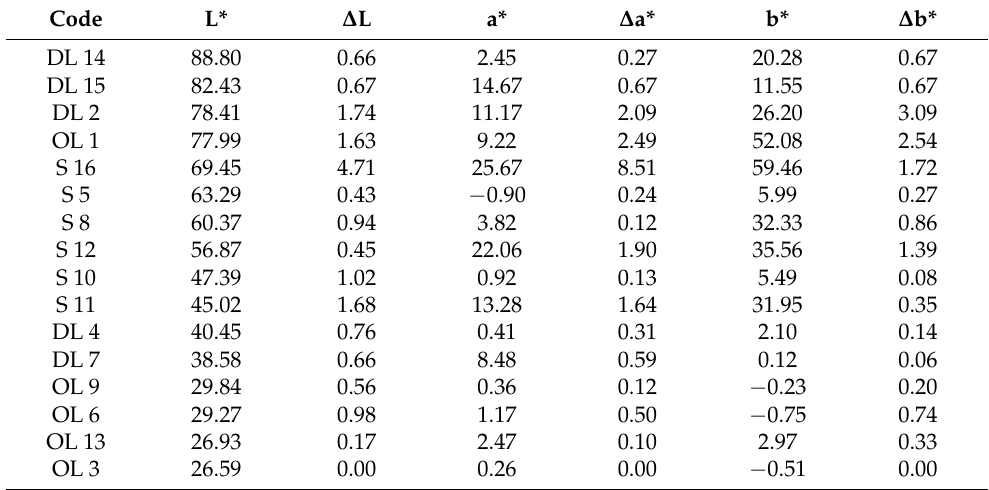
Figure 5. Original digital image of amber beads with spots where the measurements were taken. Table 7. Average color measurements of Amber 3 sorted from largest to smallest